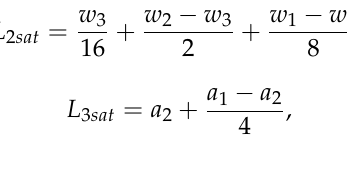
Figure 8. Dimensions of magnetic E-core for modified reluctance calculation.